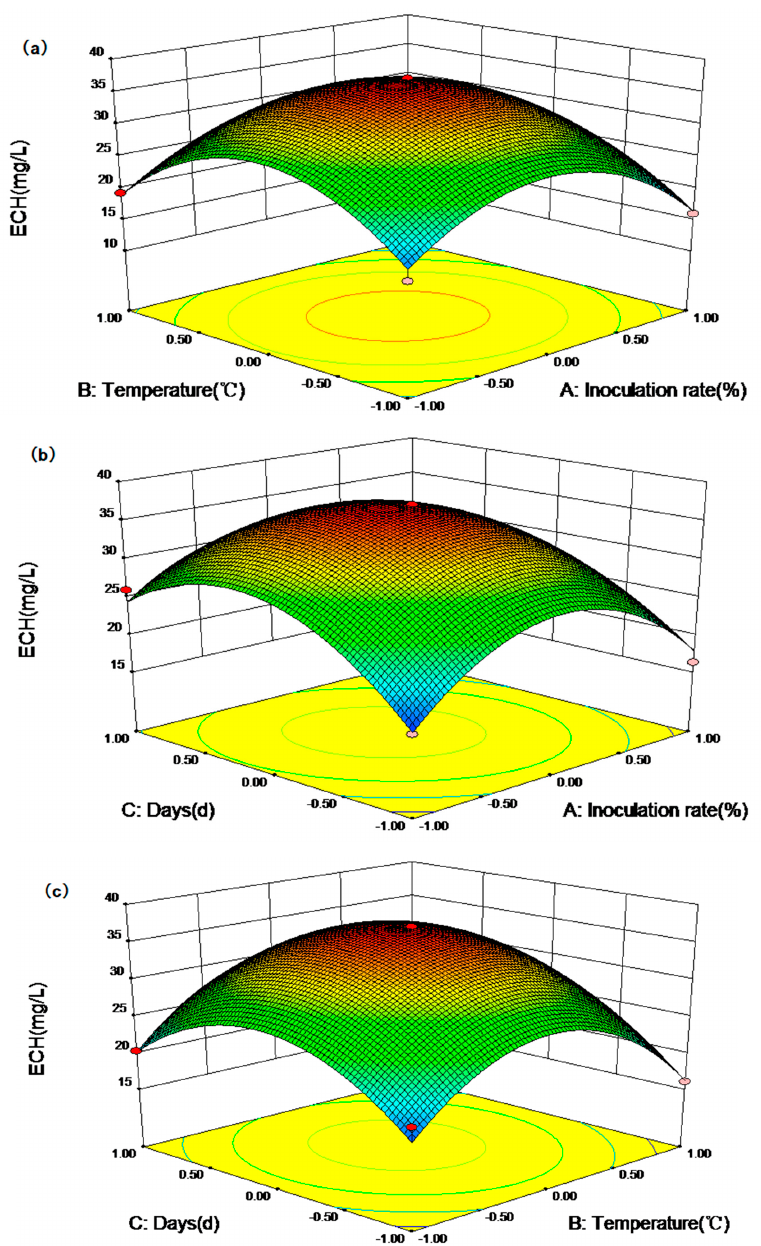
Figure 5. Response surface curves of ECH production: the interaction between inoculation rate and temperature ( a ); the interaction between inoculation rate and days ( b ); and the interaction between temperature and days ( c ).